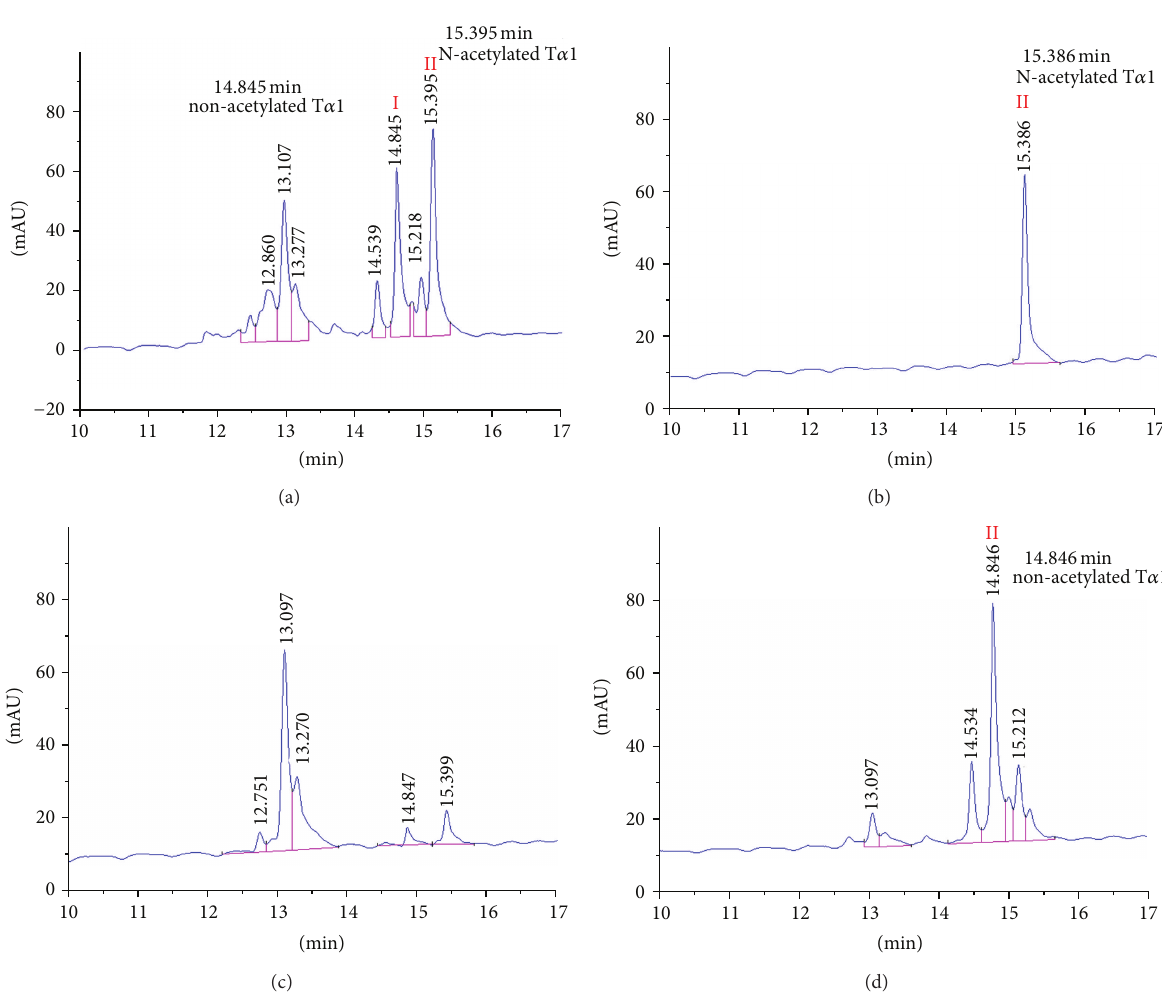
Figure 3: RP-HPLC analysis of N 𝛼 -acetylated T 𝛼 1. (a) Sample purified by PoRos R50 column was analyzed by RP-HPLC and eluted as two peaks, I and II corresponding to nonacetylated T 𝛼 1 (14.846min) and N 𝛼 -acetylated T 𝛼 1 (15.396min). (b–d) RP-HPLC analysis of samples eluted from SP column with (b) 0.2 M NaCl, (c) 0.3 M NaCl, and (d) 0.5M NaCl. N 𝛼 -acetylated T 𝛼 1 was washed out in 0.2 M NaCl